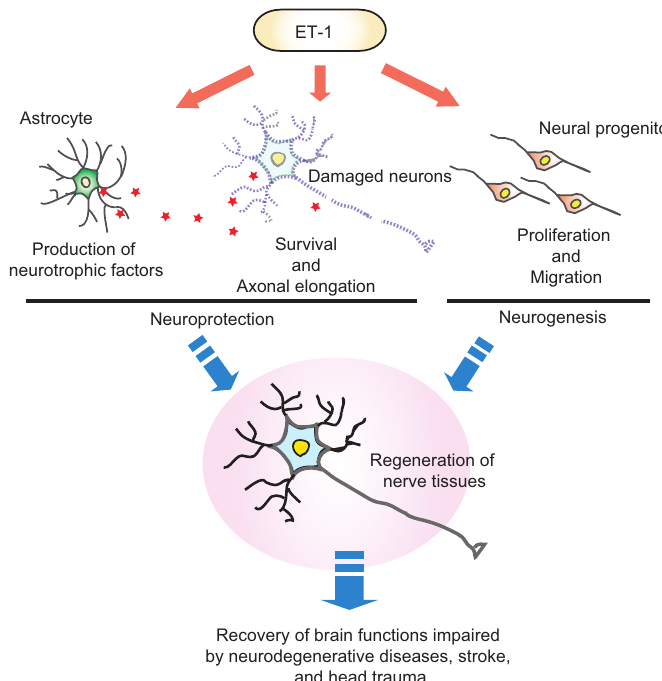
Figure 5 Possible roles of ET receptors in survival and regeneration of damaged nerve tissues. B In some neuronal cells, direct activation of ET receptors has been shown to induce antiapoptotic actions. Neuronal survival and regenera- B tion is promoted by neurotrophic factors. Production of neurotrophic factors is stimulated by activation of astrocytic ET progenitors express ET receptors. Proliferation and migration of neural progenitors are stimulated by ETs. These actions raise the possibility B that activation of ET receptors promotes repair of damaged nerve tissues in neurodegenerative diseases and in the chronic phase of B